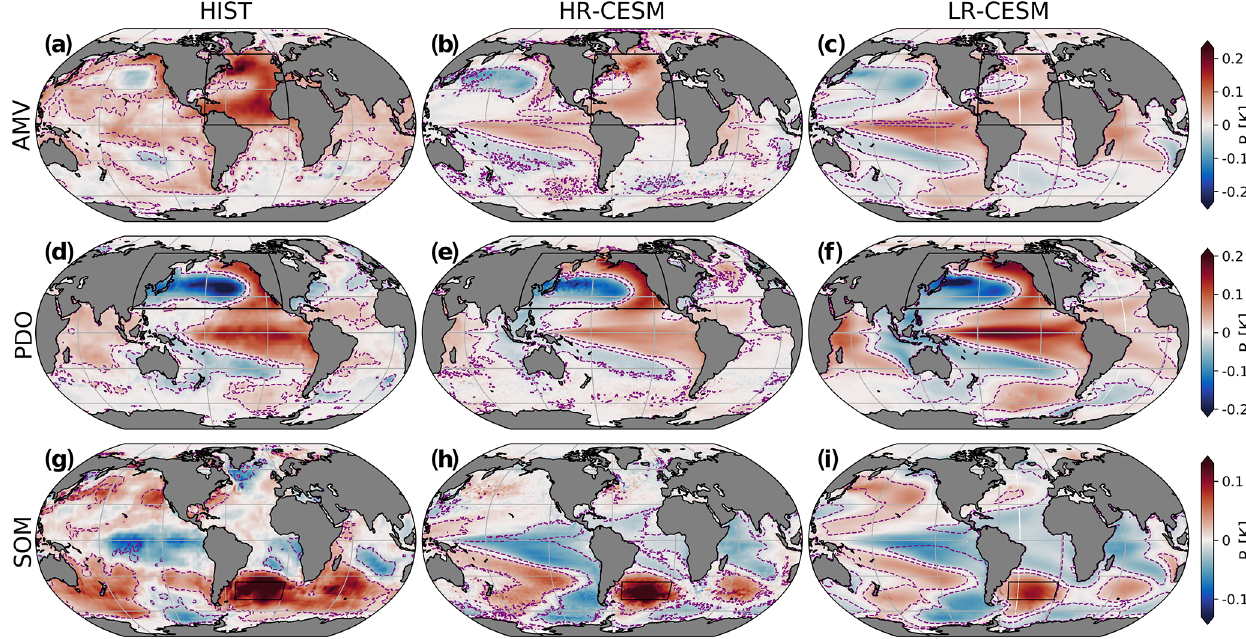
Figure 3. Regression maps (values of R(x,y) as in Eq. (3 in kelvin) of the detrended SST fields onto the AMV (a–c) , PDO (d–f) , and SOM (g–i) indices for the 149-year detrended HadISST historical dataset (left) and the 250-year datasets of HR- (center) and LR-CESM (right) simulations. Purple dashed lines demarcate the areas of significant correlations at the 98% level. Black boxes outline the index areas. Parallels and meridians are drawn every 30 and 60 ◦ , respectively. Note the different color bar